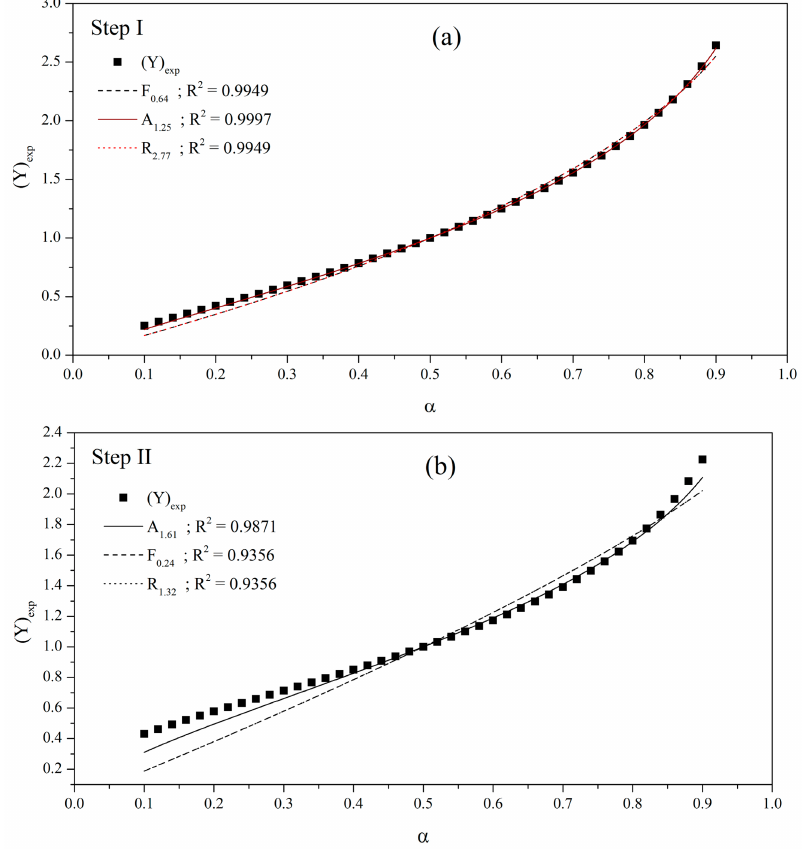
Figure 8. The fitted non-linear curves of ( a ) the first and ( b ) the second steps from the master plots combined with the non-linear curve fitting method. Comparative results between the experimental and model plots for ( a ) the first and ( b ) the second individual peaks obtained from Y( α ) plots of the studied thermal solid-state